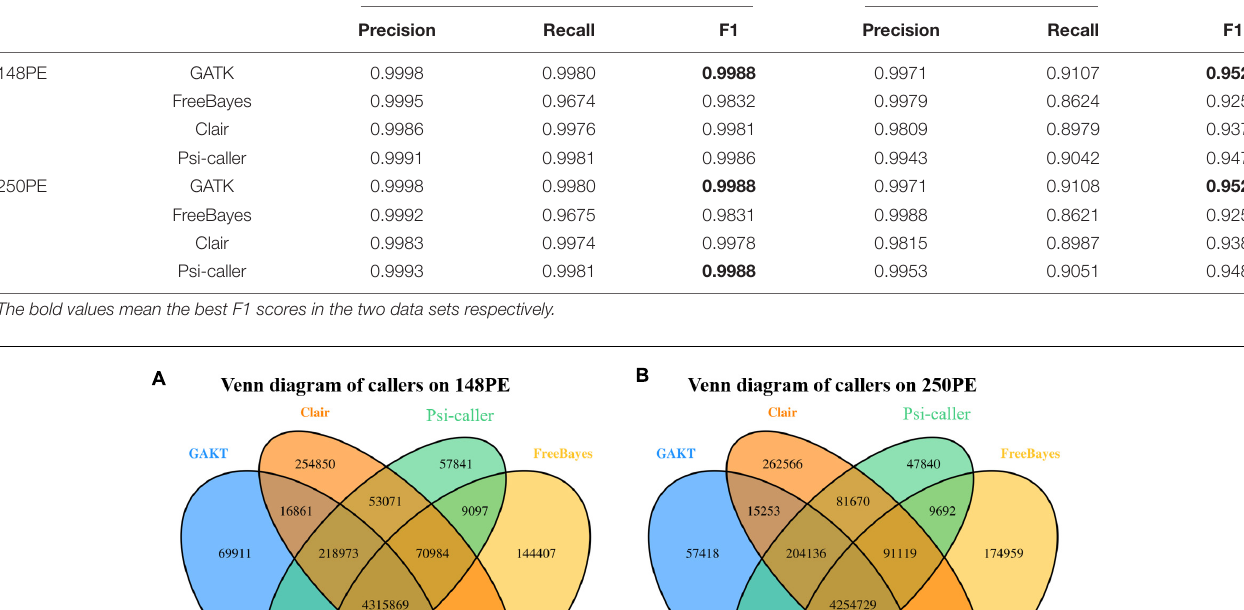
TABLE 1 | Results of simulation benchmarks for various callers. Data